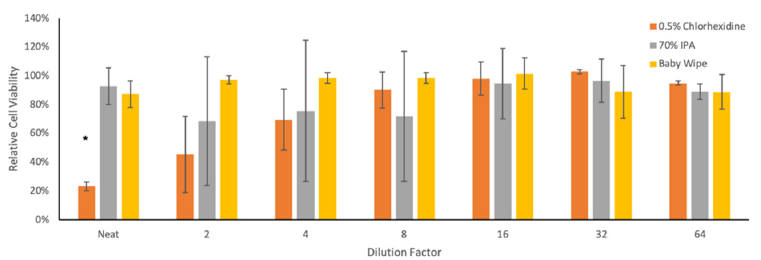
Figure 3. Cellular cytotoxicity of neutralization solutions. Values are expressed relative to samples exposed to the same dilution of water in growth medium. N = 3; * cell viability significantly decreased relative to corresponding water control ( p < 0.05).